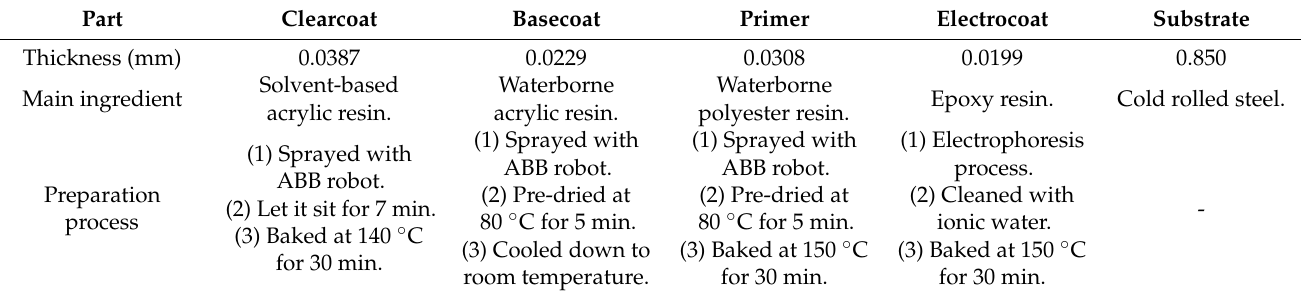
Figure 1. SEM photograph of the cross-section of the automotive coating sample. Table 1. The thickness, main ingredient, and preparation process of each part of the automotive coating sample.